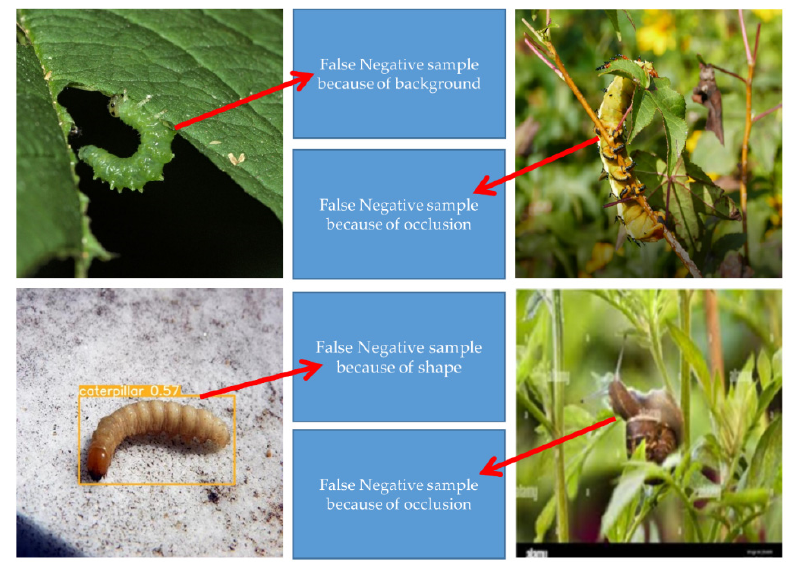
Figure 14. Common problems encountered in our object detection system.